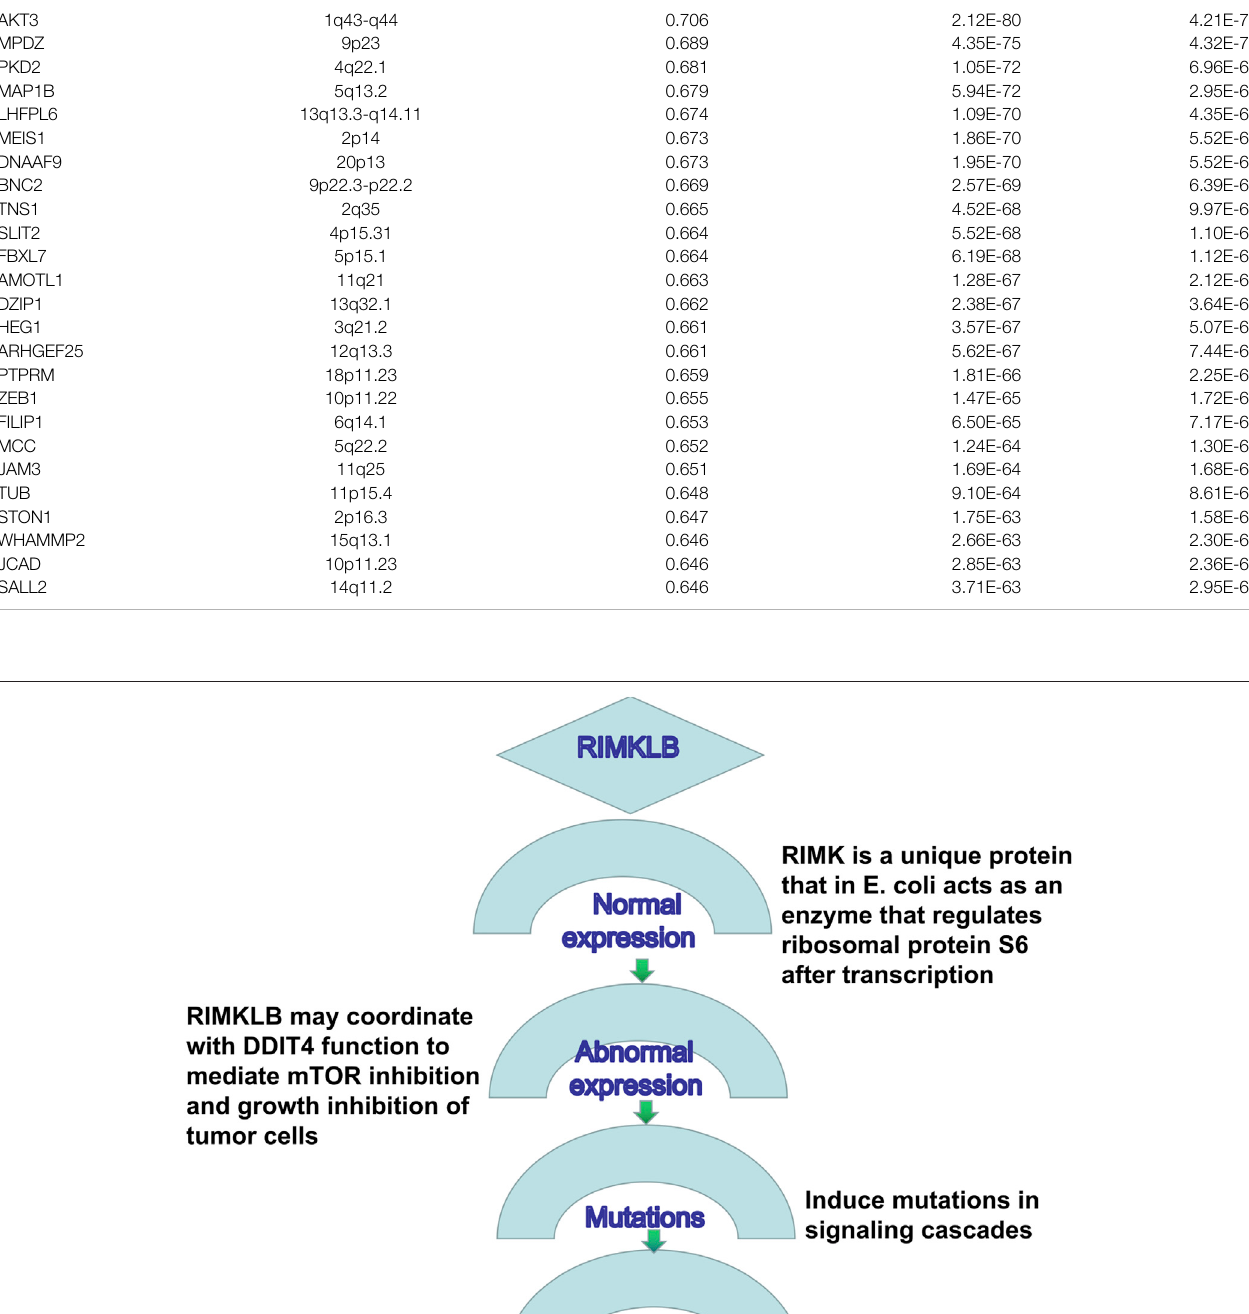
TABLE 3 | TOP genes positively correlated with RIMKLB in CRC. Correlated gene